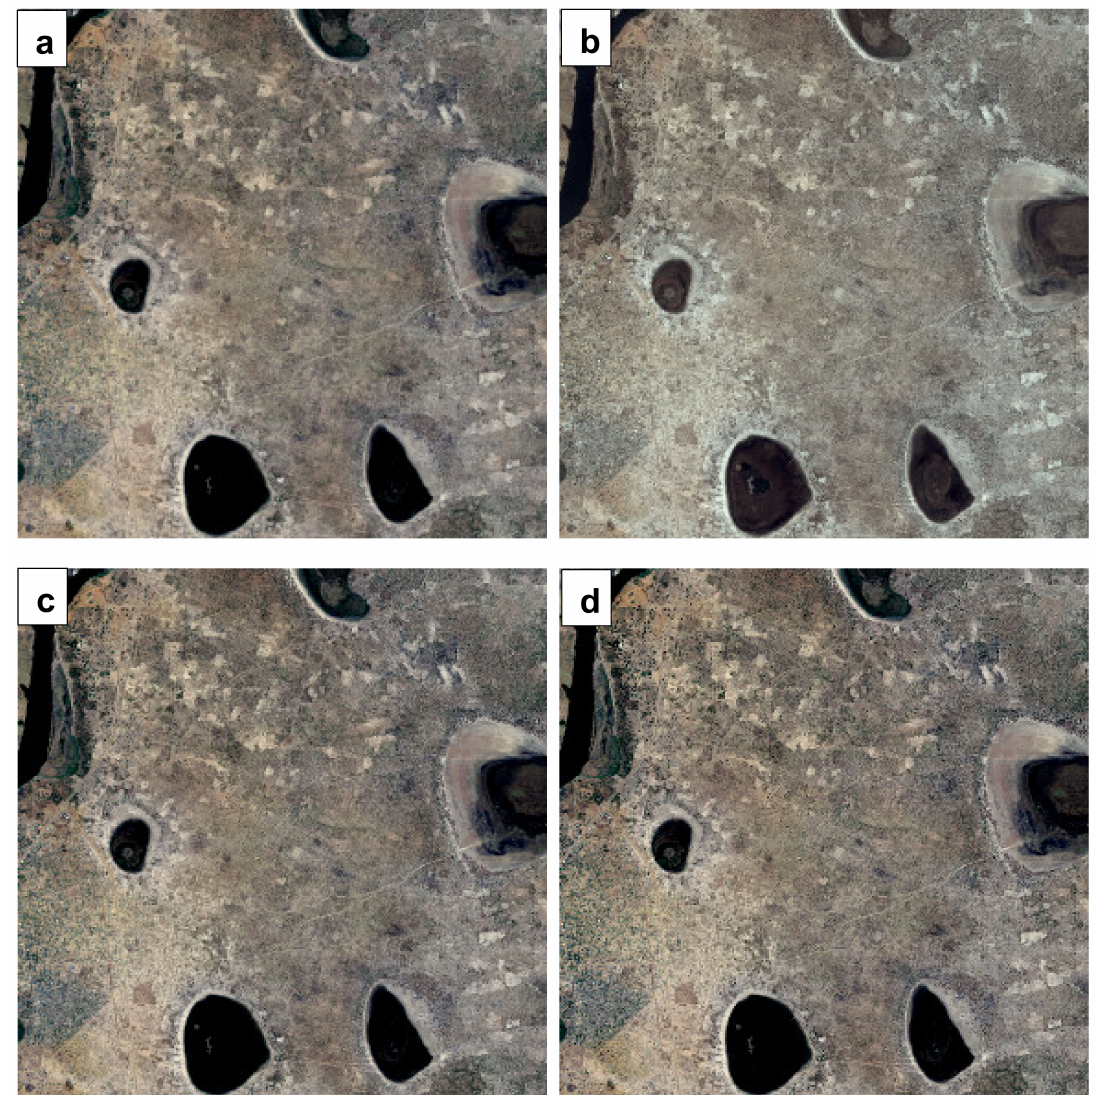
Figure 3. Study site 3 true color surface reflectance images, composed of 1800 × 1800 3.333 m pixels covering 6 × 6 km ( a ) Sentinel-2 reflectance bilinear resampled from 10 m, ( b ) Planetscope reflectance, ( c ) Sentinel-2 HPM sharpened from 10 m, and ( d ) Sentinel-2 M3 sharpened from 10 m. Images oriented with north at the top of the image. Site and image dates summarized in Table